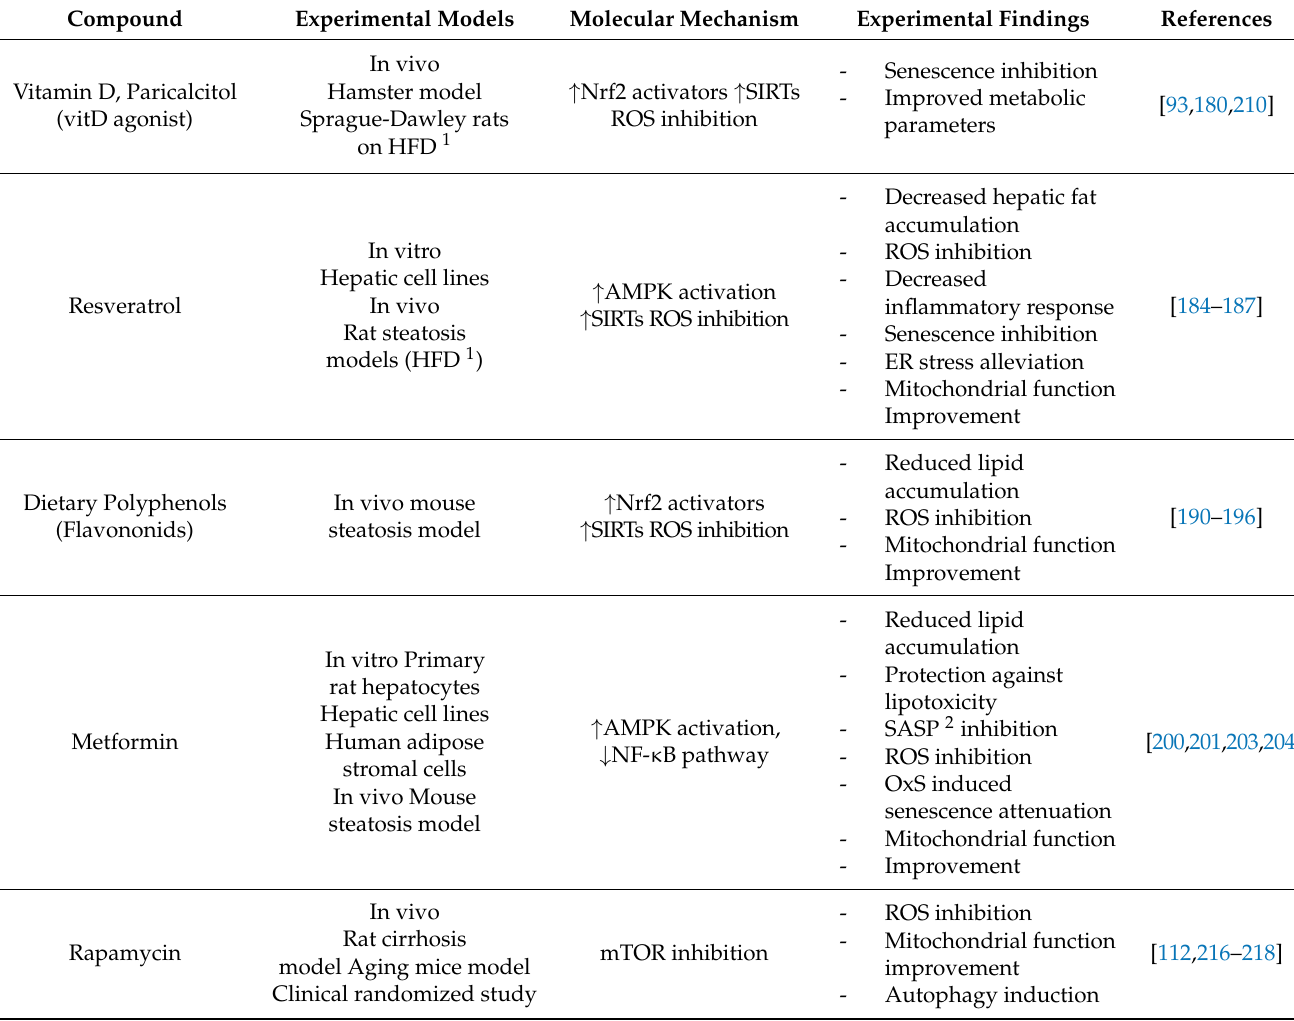
Table 3. Modulators of oxidative stress-induced senescence as a potential therapy in NAFLD.